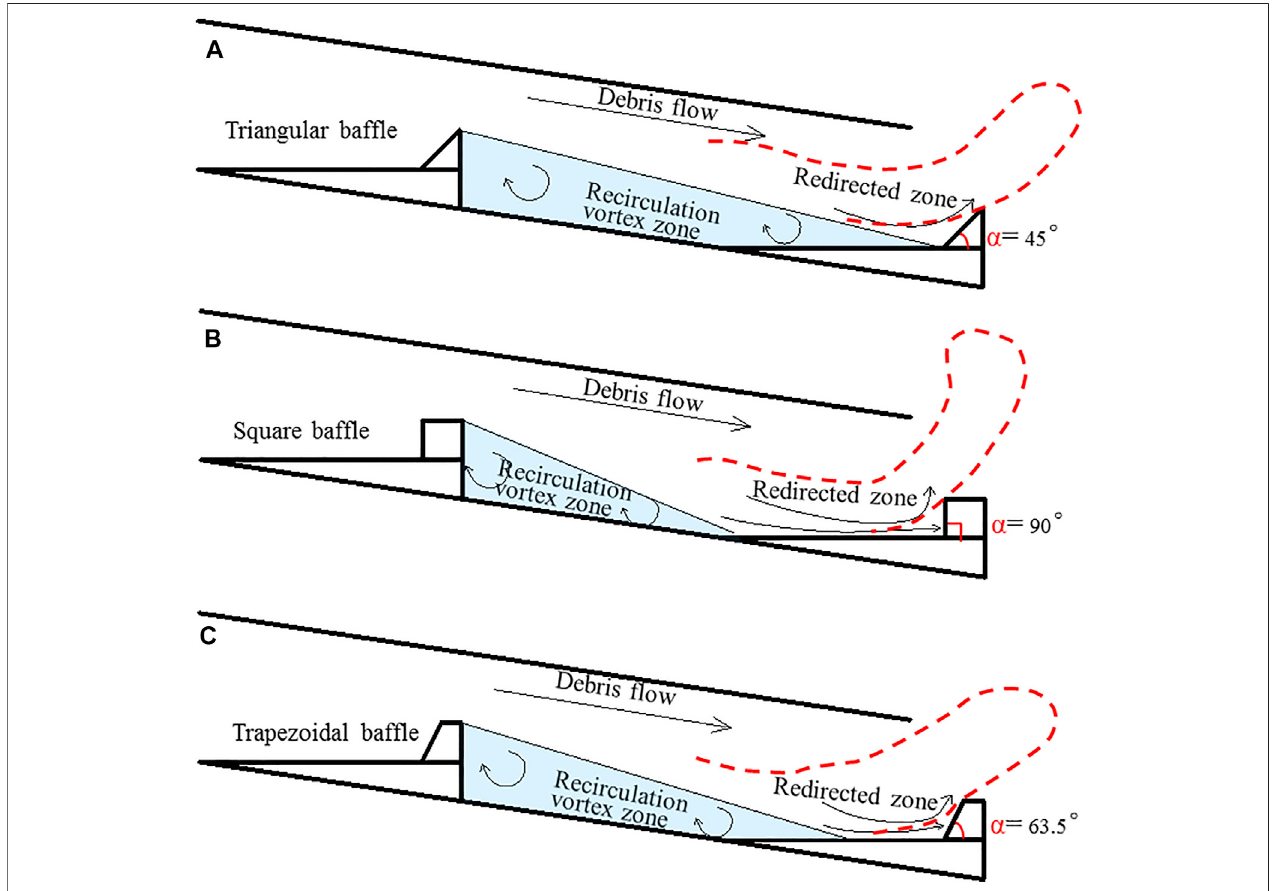
FIGURE 10 | Sketch of the fl ow structure of debris fl ows passing over (A) triangular (B) square and (C) trapezoidal baf fl es.